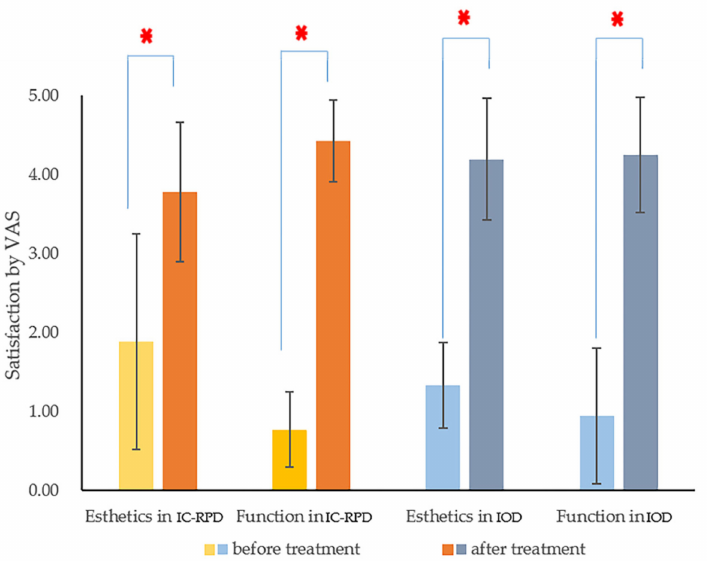
Figure 6. Comparison of satisfaction (esthetic and function) rates by visual analog scales (VAS) before vs. after prosthetic treatment. The Wilcoxon-signed ranks test showed there were significant differences before and after treatment in both esthetics and function regardless of treatment modality ( p < 0.05). Asterisks indicated p < 0.001.